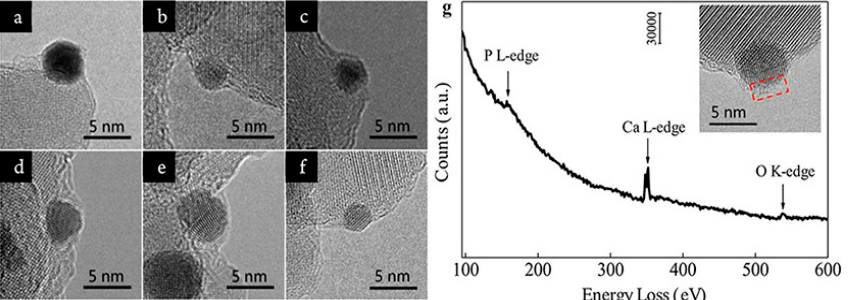
Figure 5. ( a – e ) HRTEM images of Au/H-X samples where “H” represents HAP and “X” represents the calcination temperature: ( a ) Au/H-200, ( b ) Au/H-300, ( c ) Au/H-400, ( d ) Au/H-500, and ( e ) Au/H-600; ( f ) HRTEM image of sample obtained by further reducing Au/H-500 at 500 °C under H 2 . ( g ) The electron energy loss spectrum (EELS) spectrum of Au/H-600 where the Au nanoparticles were completely encapsulated. Reproduced with permission from [45], copyright: 2016 by the American Chemical Society.